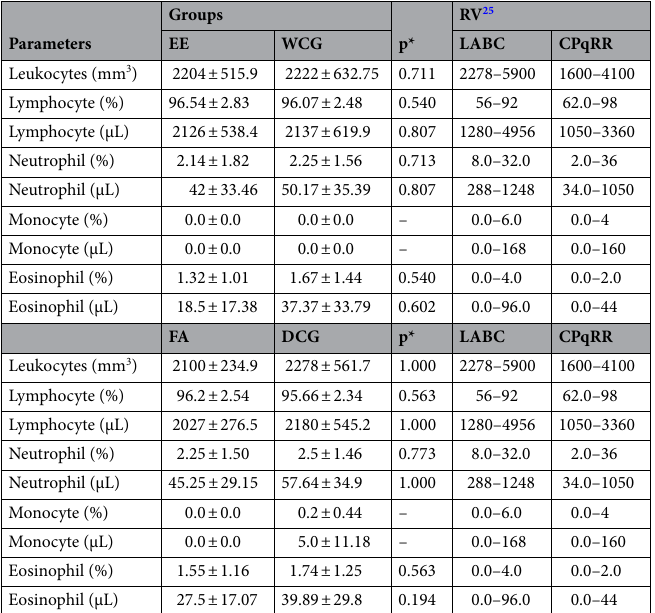
Table 7. Leukogram in mice treated with repeated doses of ethanolic extract or alkaloid fraction from Aspidosperma nitidum. EE ethanolic extract, FA fraction of alkaloids, WCG water control group, DCG DMSO control group (99% water + 1% DMSO), RV reference value, LABC Laboratory Animal Breeding Center, CPqRR René Rachou Research Center. * p value was obtained by Student’s T-test, comparing EE versus WCG, or FA versus DCG.